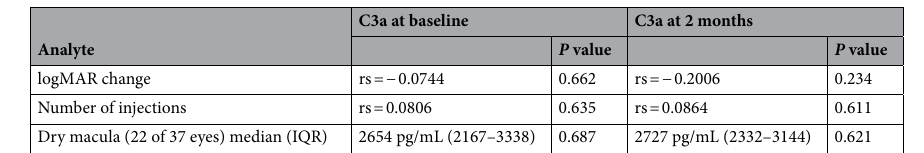
Table 4. C3a and treatment outcomes at twelve months. rs: correlation of Spearman’s analysis. C3a, complement component 3a; VEGF, vascular endothelial growth factor.